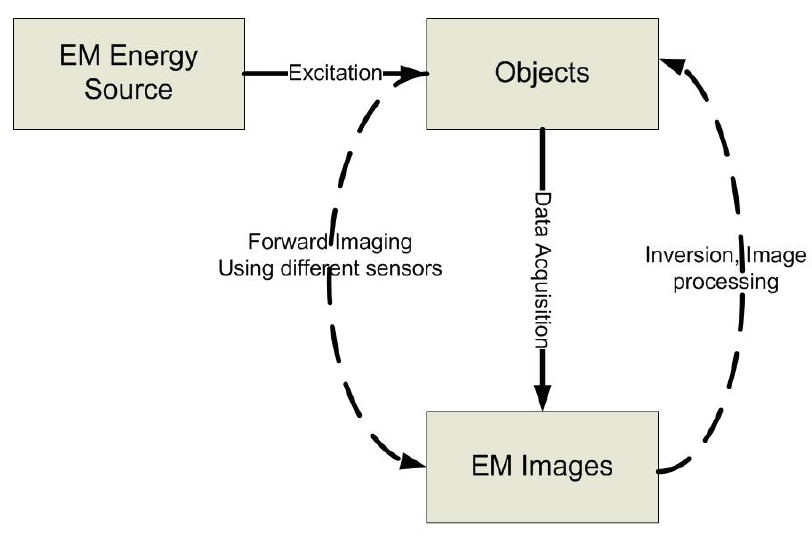
Figure 1. General schematic of electromagnetic NDE imaging